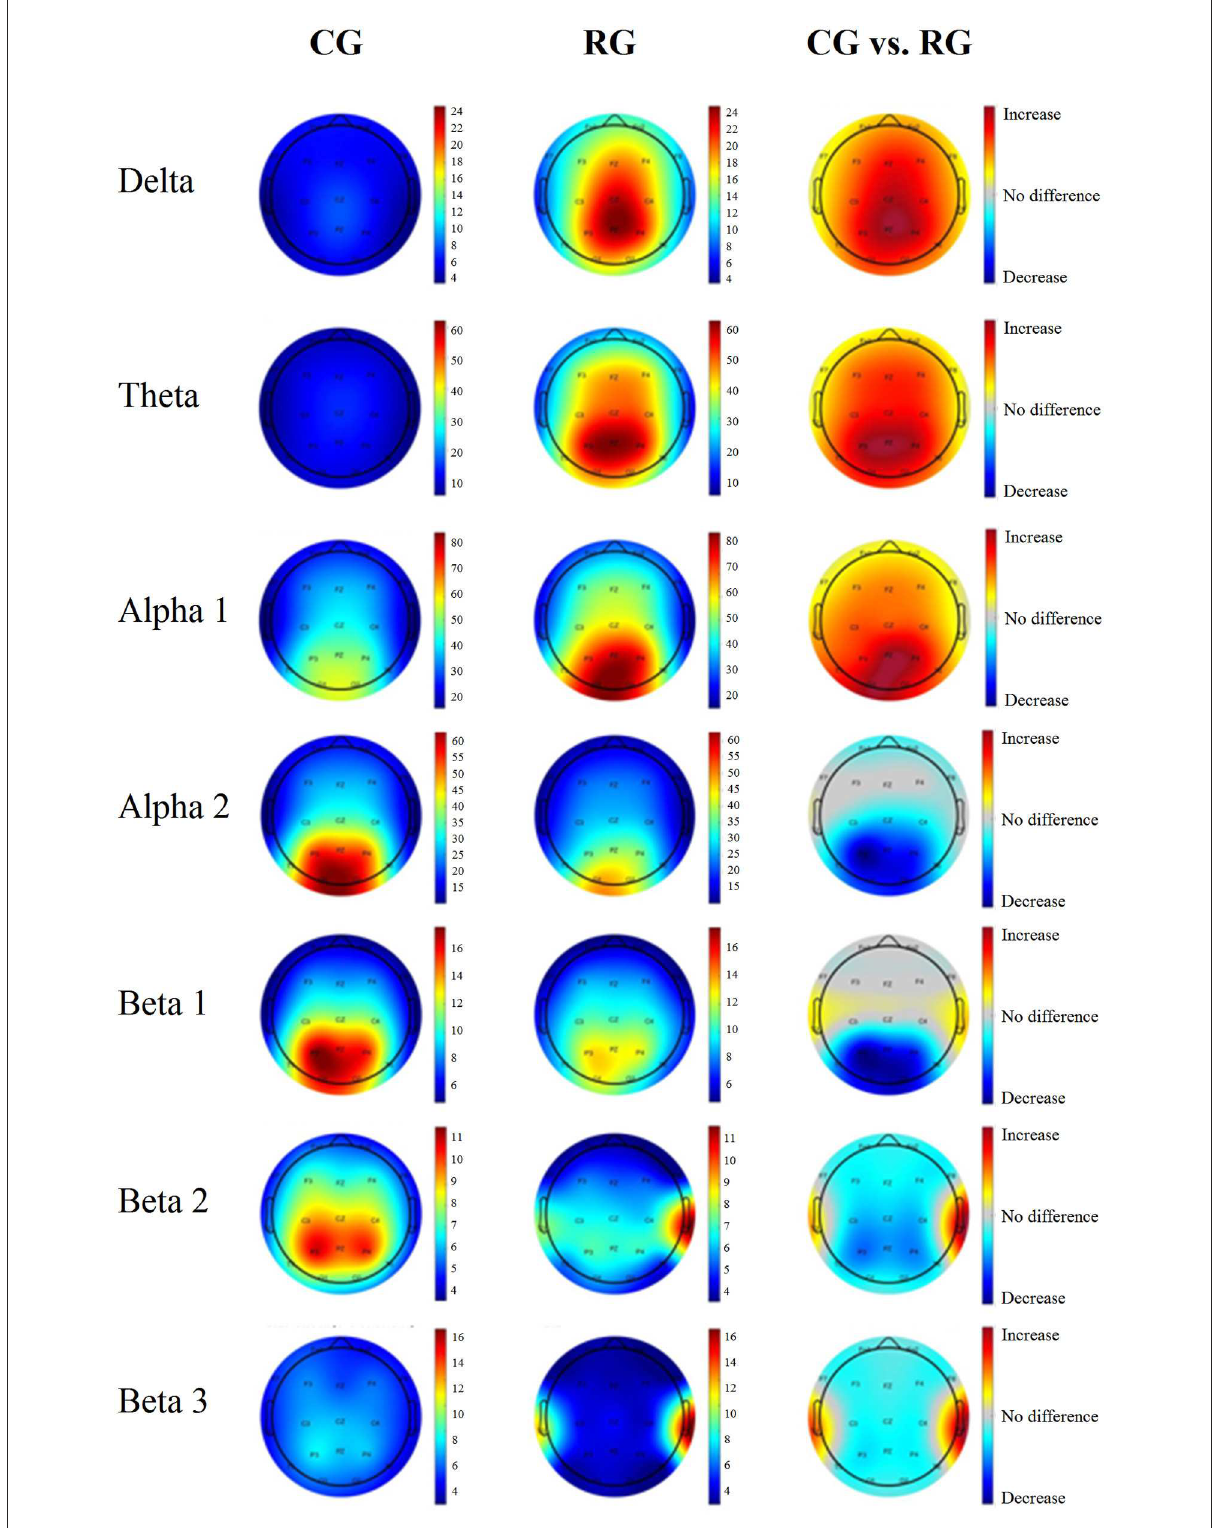
FIGURE2 Average power maps per group and probability maps of the differences in the surface level EEG. The first column corresponds to the CG, and the middle column corresponds to the RG. The last column corresponds to the significance values from the comparison between the groups. Warm colors indicate that the risk group AP values are higher than those of the control group. Cool colors represent lower AP values in the risk group than in the control group. Only the areas that exceeded the probability threshold ( p = 0.05) are colored. The rows represent each frequency